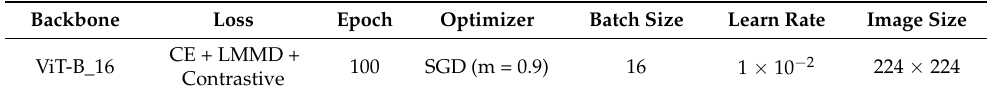
Table 2. Training parameters of recognition model.